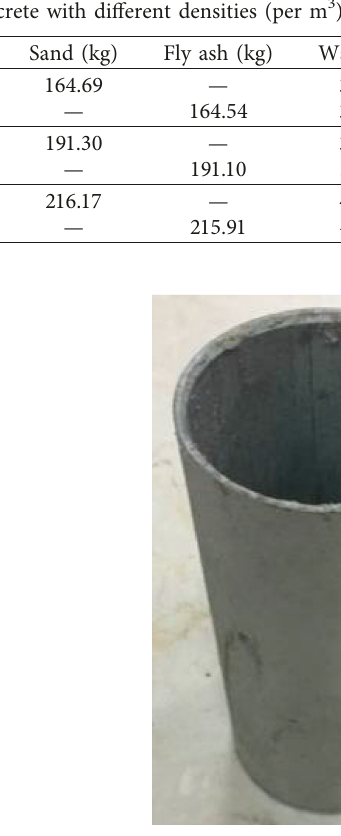
Figure 2: Ø50 × 50 plastic mould. Figure 3: Ø50 × 100 aluminium